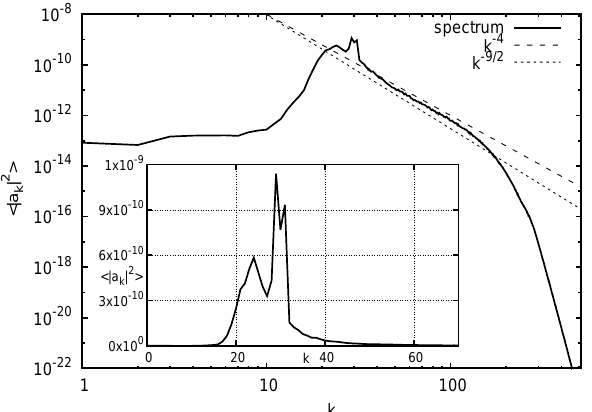
Figure 1. Angle-averaged spectrum with both the condensate and inverse cascade suppressed. Slopes for the KZ spectrum and Phillips spectrum are shown for reference by dashed and dotted lines respec- tively. Main figure: logarithmic scale; inset: linear scale.